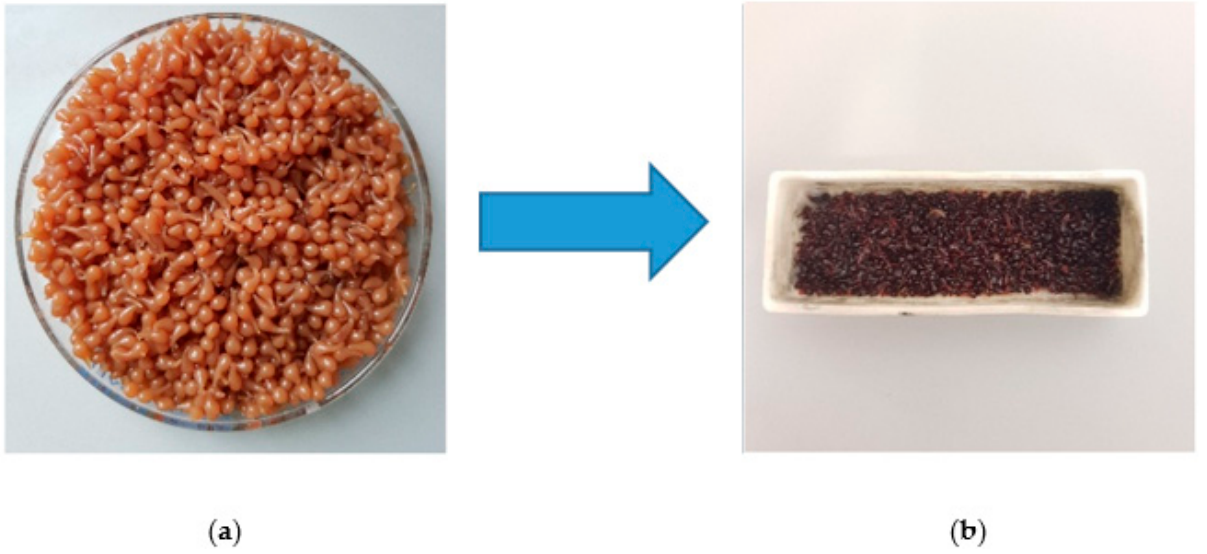
Figure 1. ( a ) Lanthanum strontium cobalt ferrite-alginate (LSCF-ALG) wet beads and ( b ) dried beads.